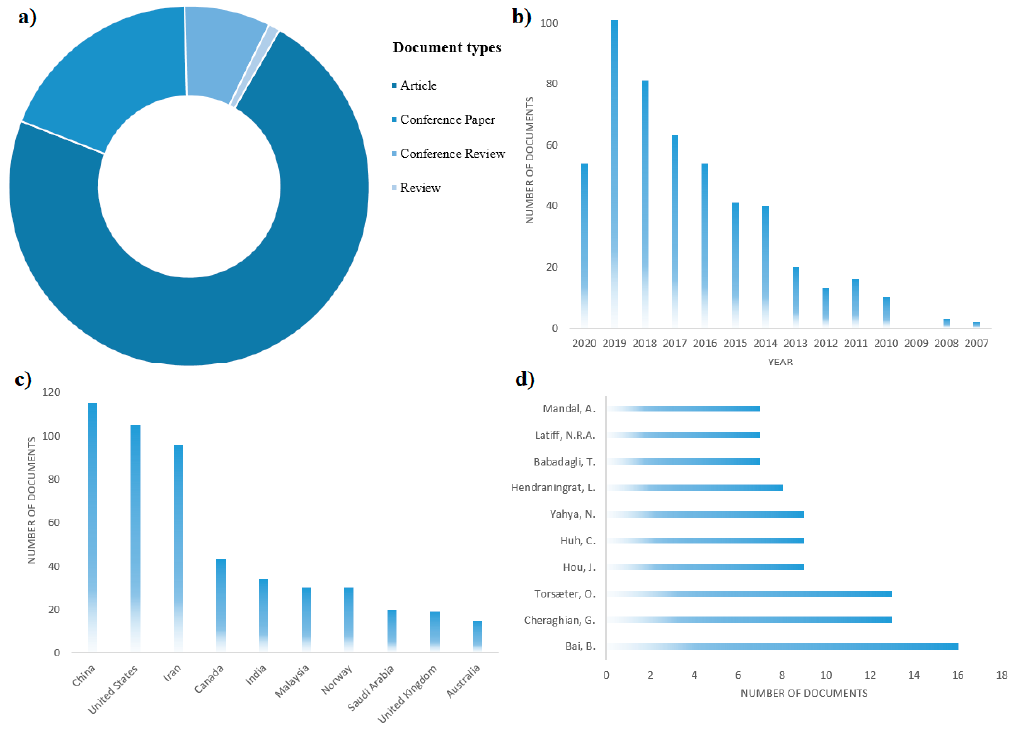
Figure 3. ( a ) Types of documents, ( b ) the number of documents per year, ( c ) the number of documents based on countries and ( d ) documents by